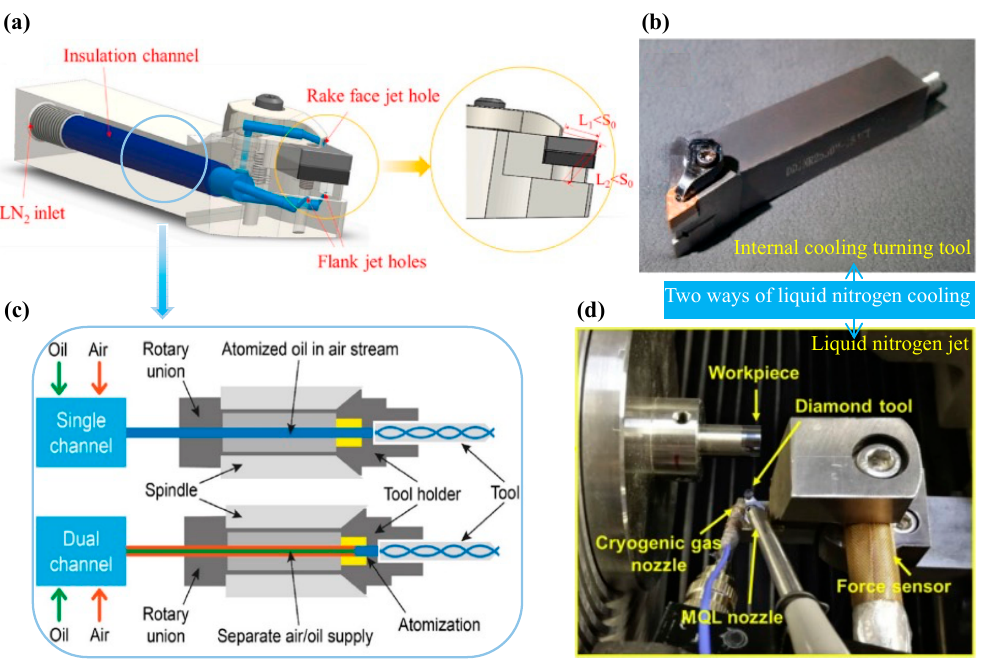
Figure 25. ( a ) 3D modeling picture of the internal cooling device of the turning tool. ( b ) Physical picture of the internal cooling device of the turning tool, adapted with permission from Ref. [164] 2021, Elsevier. ( c ) Internal transfer system of MQL [174]. ( d ) Layout of the CG + MQL assisted SPDT device build, adapted with permission from Ref. [163] 2017, Elsevier.